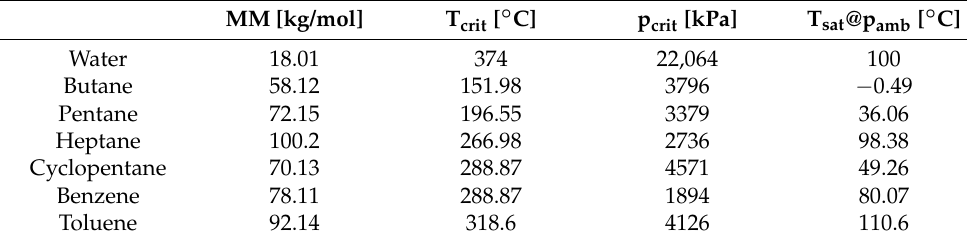
Table 5. Working fluids properties [120].